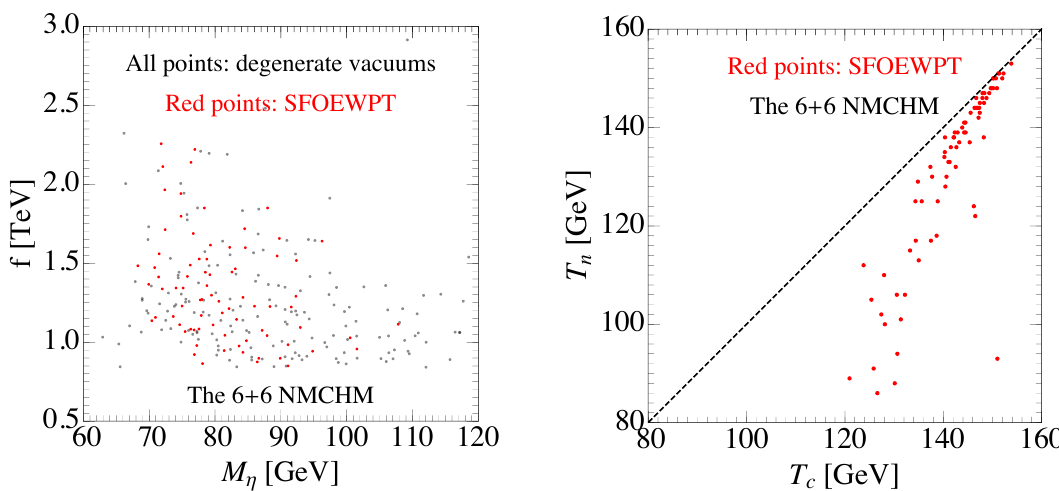
Figure 2 . Left: the projections for the parameter points on the M (cid:17) (cid:0) f plane. All the points can reproduce SM mass spectrum and give degenerate vacuums at critical temperature T c , while only the red points give SFOEWPT. Right: the T n (cid:0) T c values for the points with successful SFOEWPT. S ( T ) =T (cid:24) 3 n n